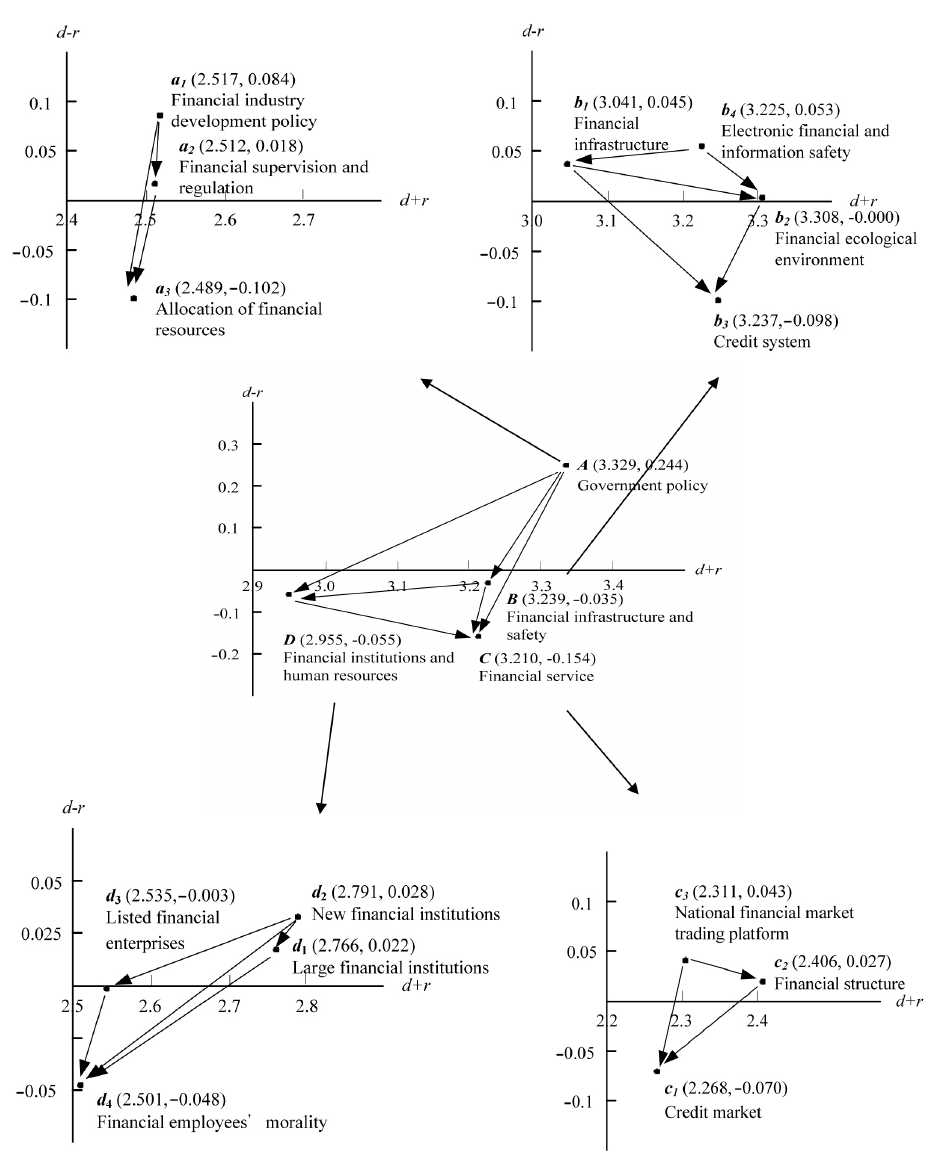
Fig. 4. The INRM of total influence relationships for the regional financial center